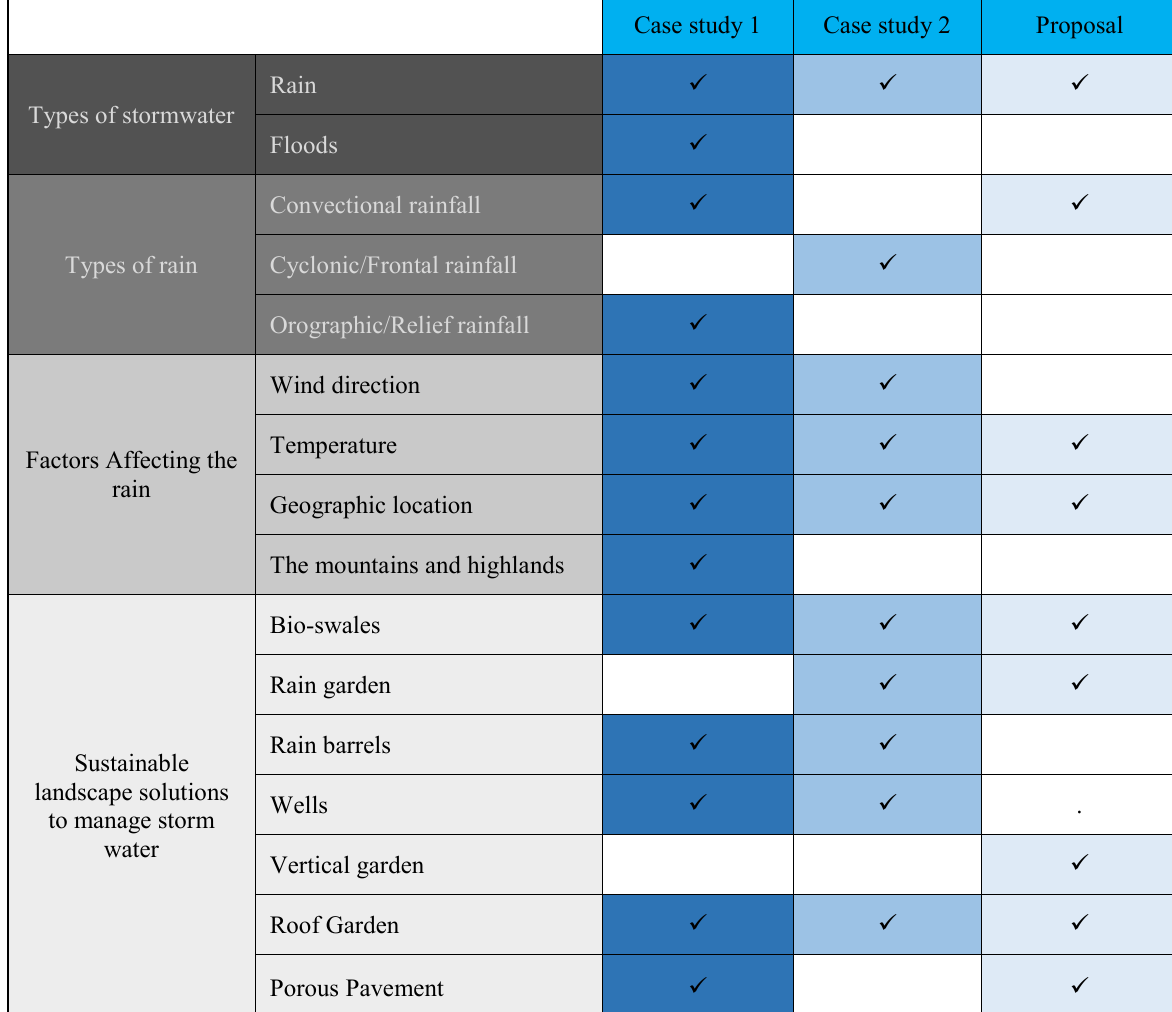
Table 7. Comparison in sustainable applications between the 2 cases and the proposed solutions. (source: the